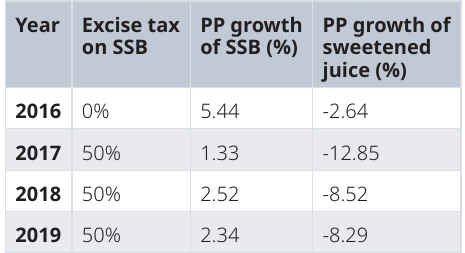
Table 1. Trends of percentage growth from previous period (PP growth) of sugar- sweetened beverages (SSB) and sweetened juice in Saudi